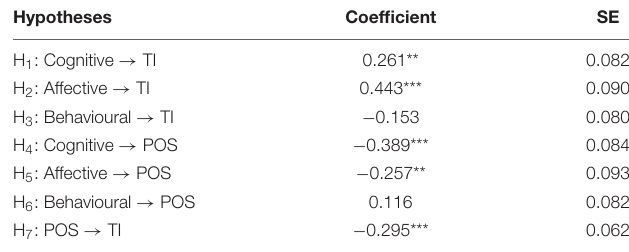
TABLE 2 | Results of the CFA.